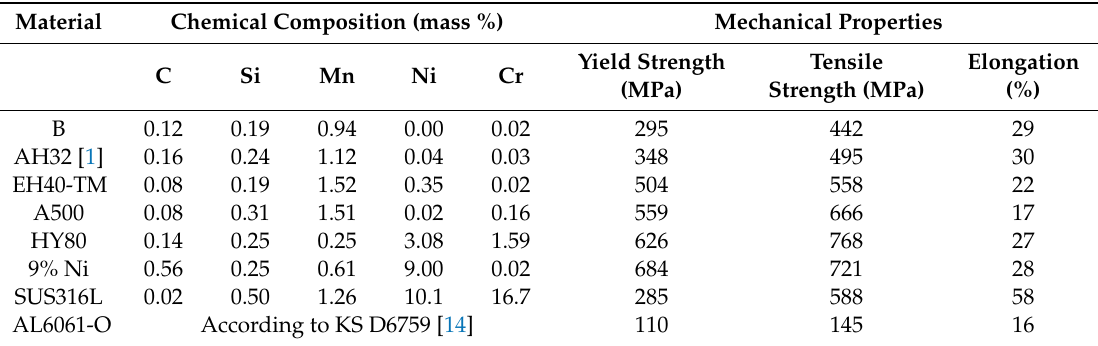
Table 1. Chemical compositions and mechanical properties of various materials.